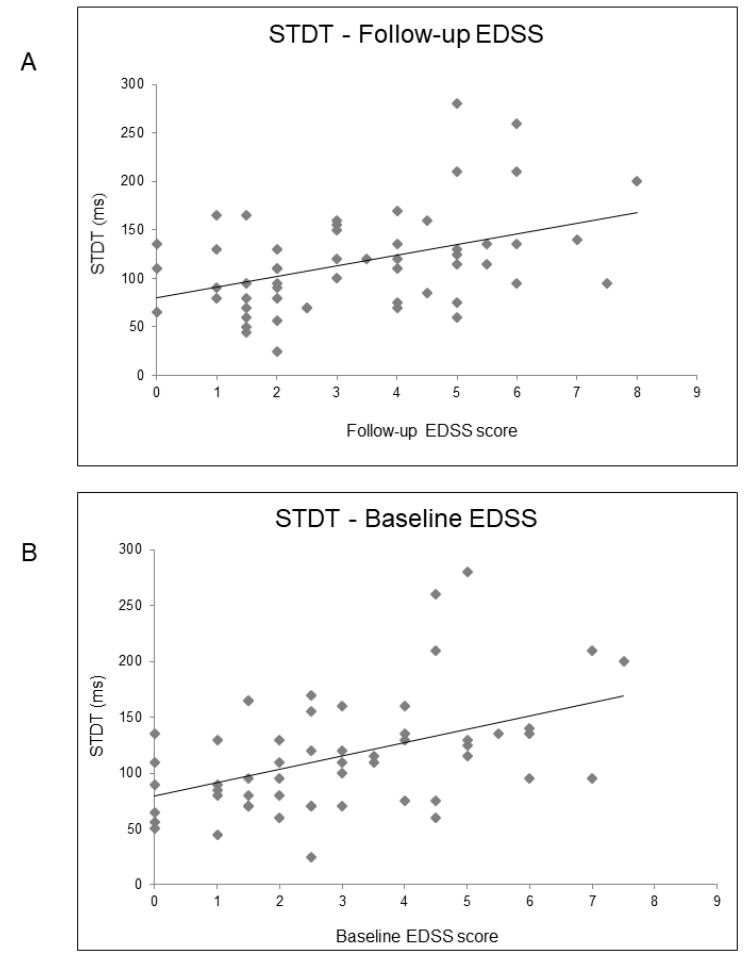
Figure 4. Relationship between STDT values and EDSS score at follow-up (Panel A ) and EDSS score at baseline (Panel B ).